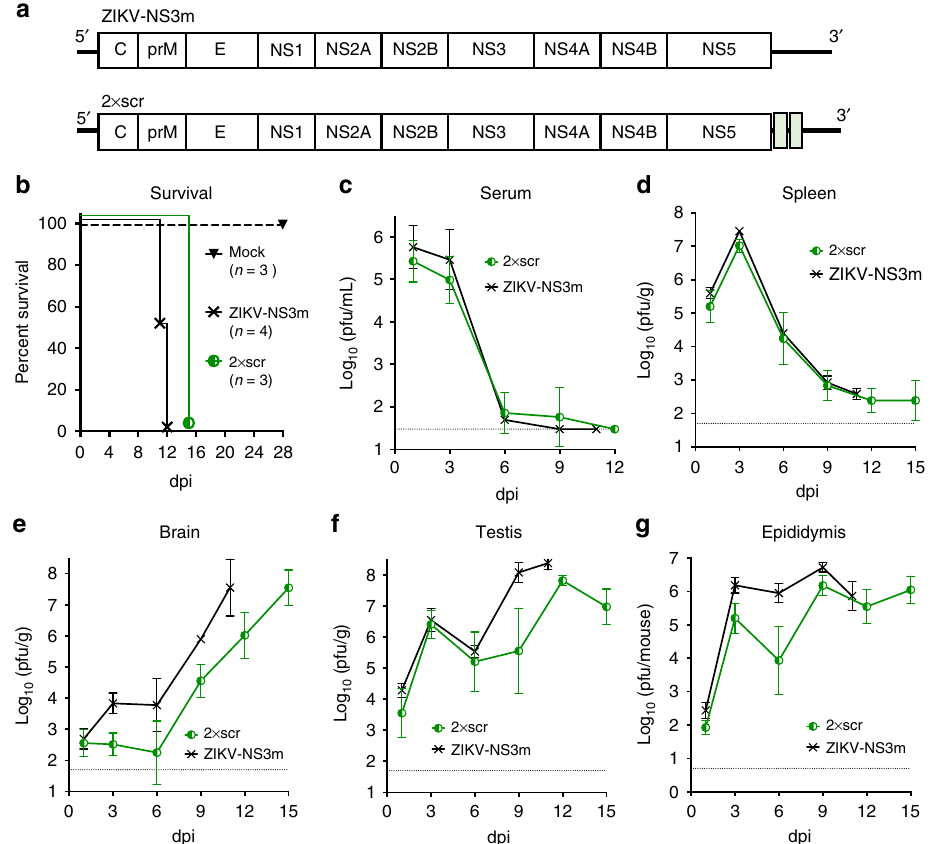
Fig. 1 Model to study the effects of miRNA targeting on ZIKV tissue tropism and pathogenesis. a Schematics of ZIKV-NS3m and 2×scr viral genomes. Green boxes indicate position of scr sequence insertions. b Survival of AG129 mice inoculated ip with 10 6 pfu of ZIKV-NS3m, 2×scr virus or with a diluent (mock). c – g Growth kinetics of ZIKV-NS3m and 2×scr viruses in the serum c , spleen d , brain e , testis f , or epididymis g of adult AG129 male mice inoculated ip with 10 6 pfu of virus. Mean viral load in the serum or organ homogenates ( n = 3 – 7 per time point) ± standard deviation (SD; shown as error bars) was determined by titration in Vero cells. The dashed lines indicate the limit of virus detection: 1.5 log 10 (pfu/mL) for serum c , 1.7 log 10 (pfu/g) for spleen, brain, or testis d – f , and 0.7 log 10 (pfu/mouse) for epididymis